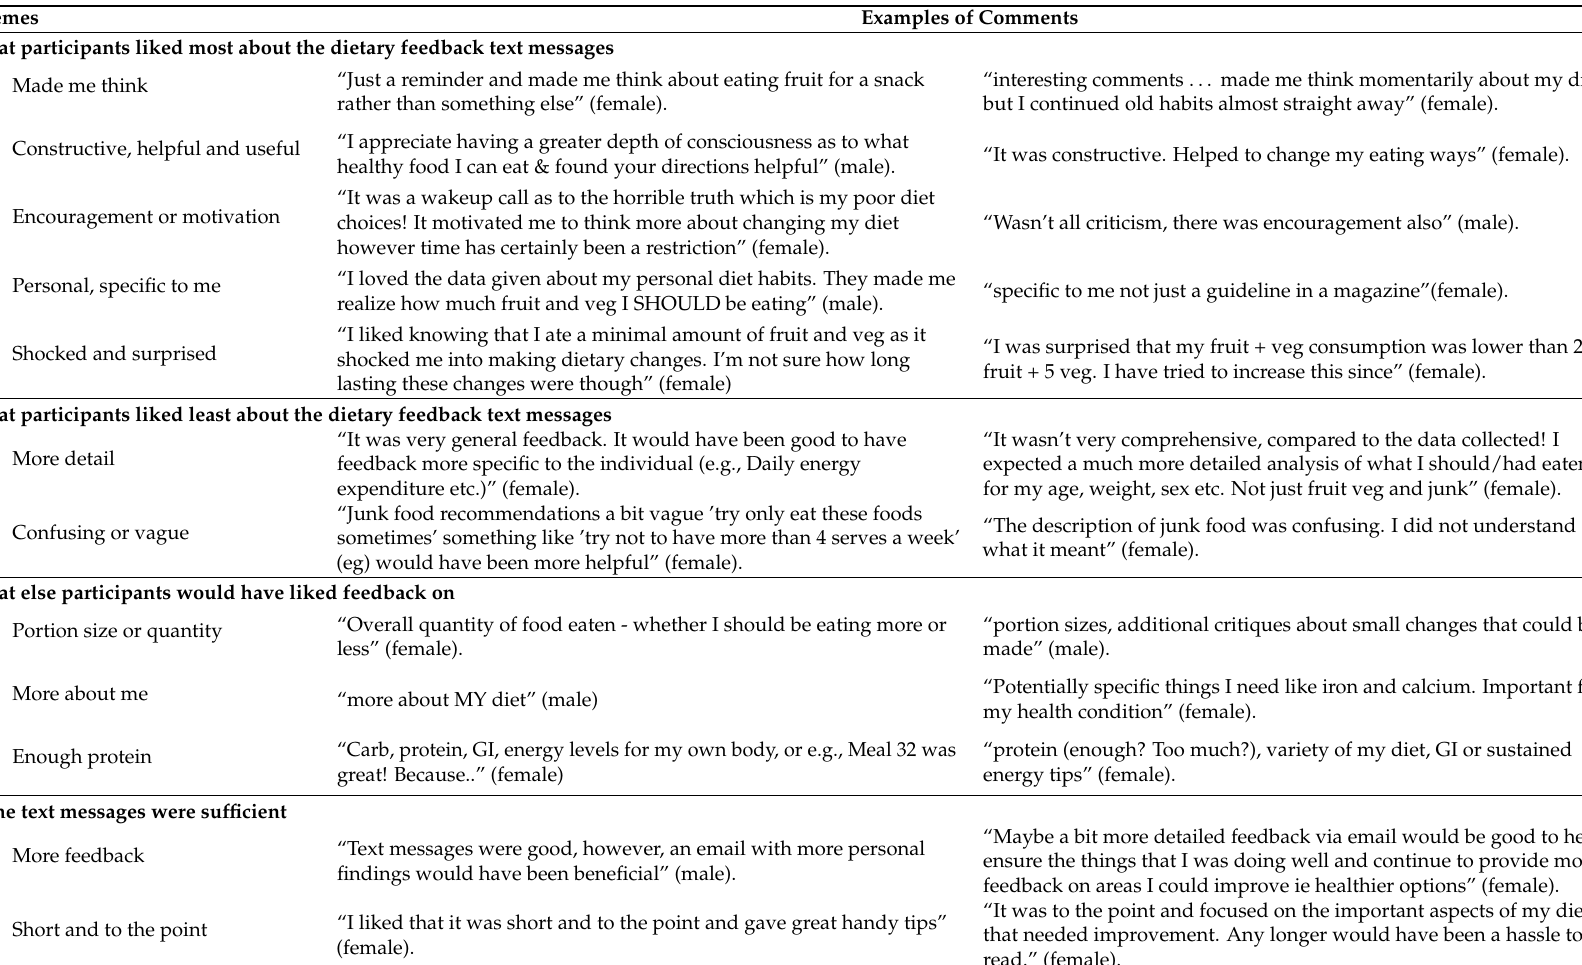
Table 4. Open-ended responses of young adults regarding dietary